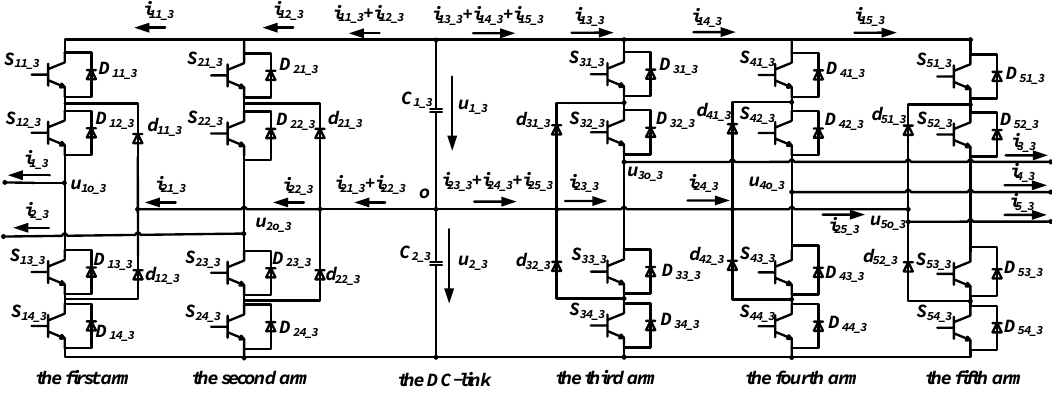
Figure 7. The topology of three-level